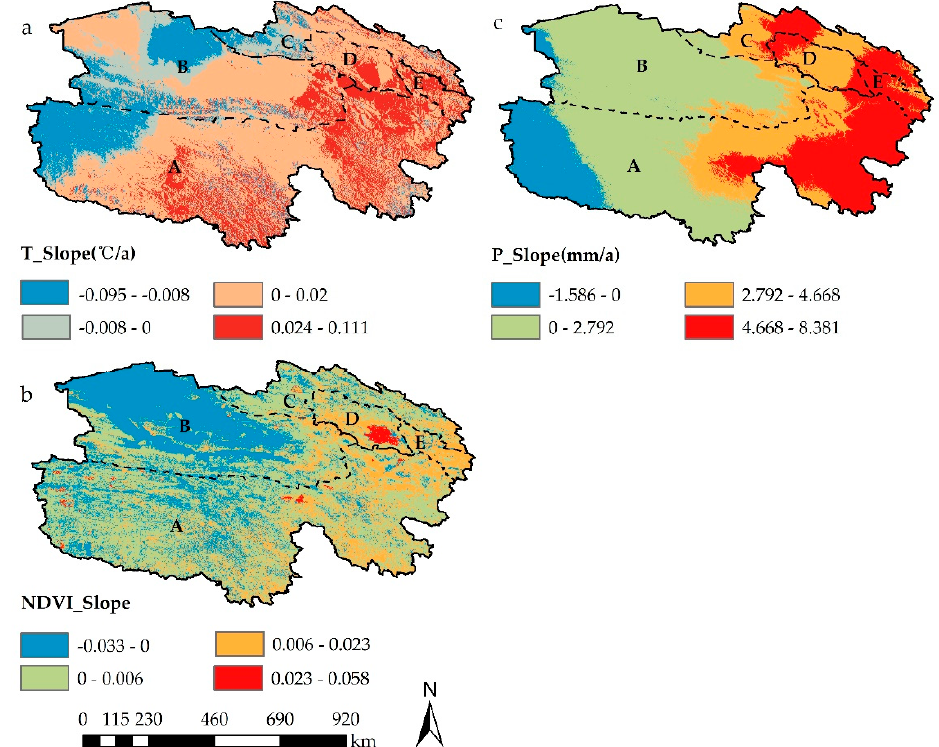
Figure 3. Spatial changes of T ( a ), NDVI ( b ), and P ( c ) in Qinghai Province during 2000–2020. A–E in the figure represents the Three-River Source region, the Qaidam Basin region, the Qilian Mountain region, the region around Qinghai Lake, and the Hehuang region, respectively.